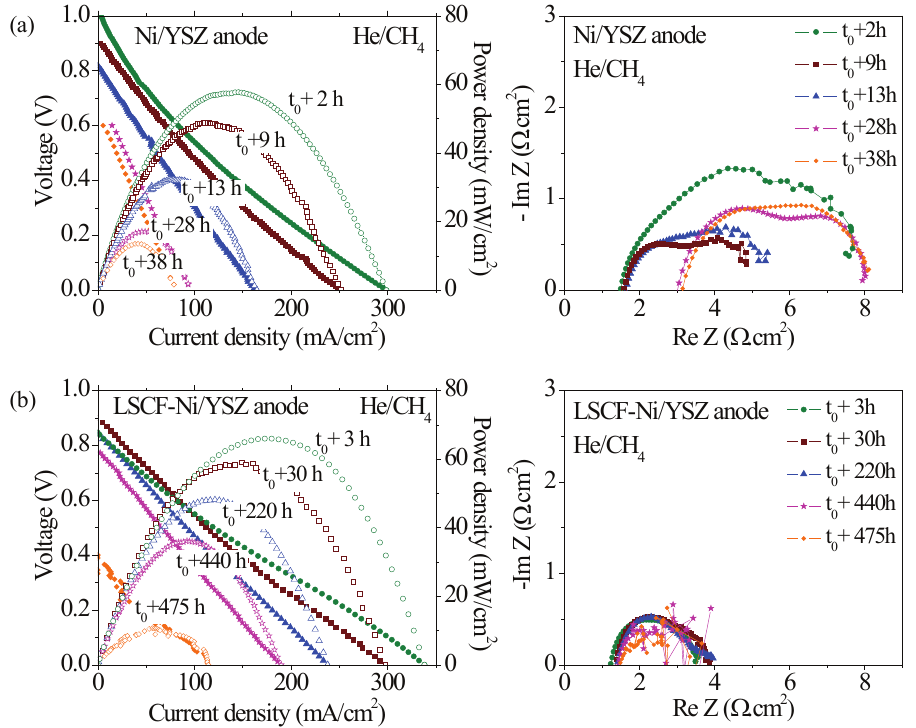
Figure 5. V–I curves and Nyquist plots of impedance spectra for the ( a ) Ni/YSZ anode, and ( b ) LSCF-Ni/YSZ anode fuel cells recorded during the long-term stability test at 750 °C in He/CH (100 sccm, 25 vol% CH 4